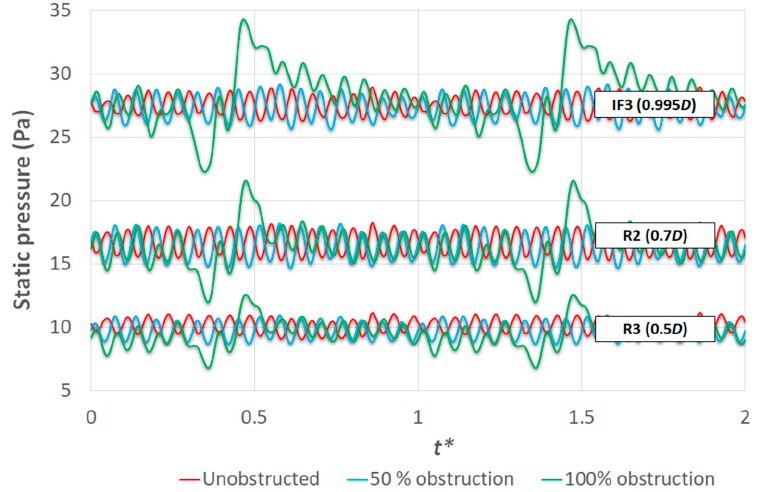
Figure 19. Pressure signal in the rotating reference frame for different distributor blockage sizes.